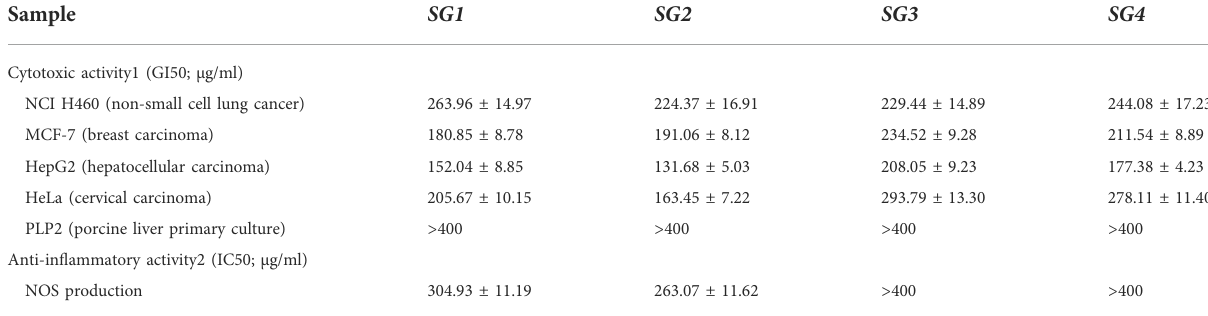
TABLE 3 Cytotoxic and anti-in fl ammatory activities of S. glutinosa extracts.